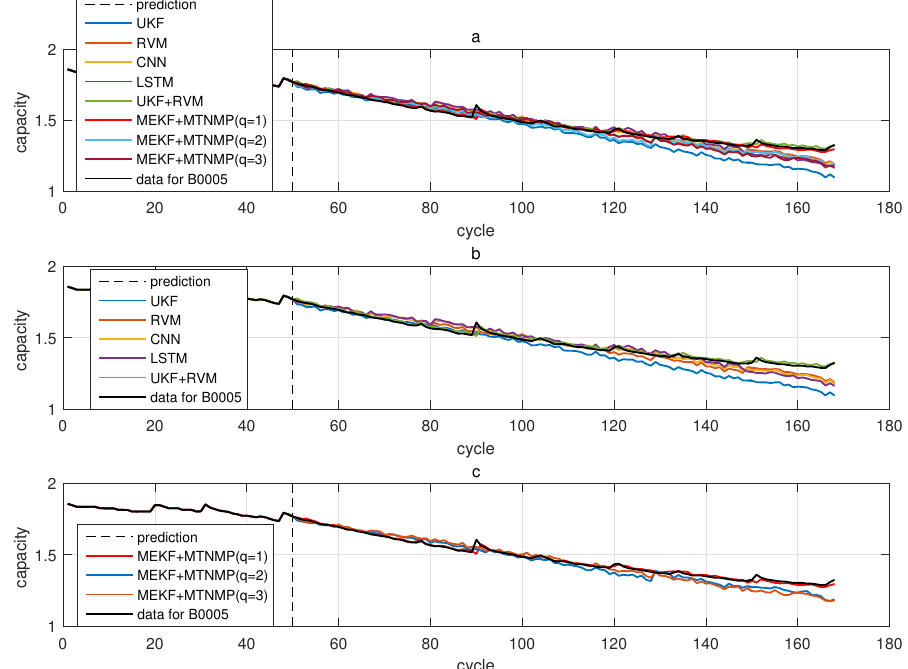
Figure 4. The simulation diagram of B0005 predicted from the 50th time. ( a ) is the experimental diagram of all methods, ( b ) is other methods used for comparison in ( a , c ) is the method proposed in this paper in ( a